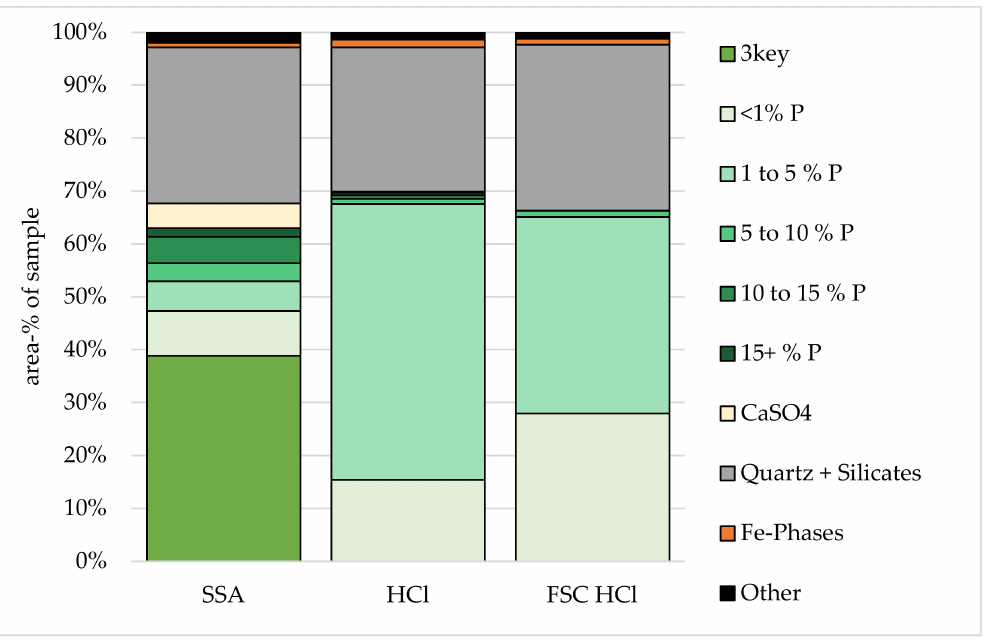
Figure 3. Composition of SSA before and after digestion with di ff erent inorganic acids evaluated with the target phase grouping